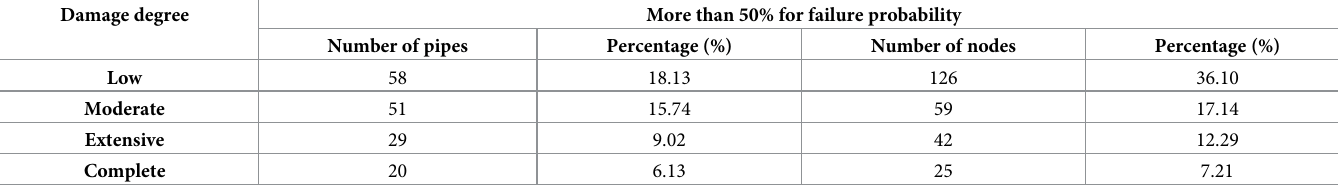
Table 5. Seismic connectivity reliability of water supply network in Shengpu